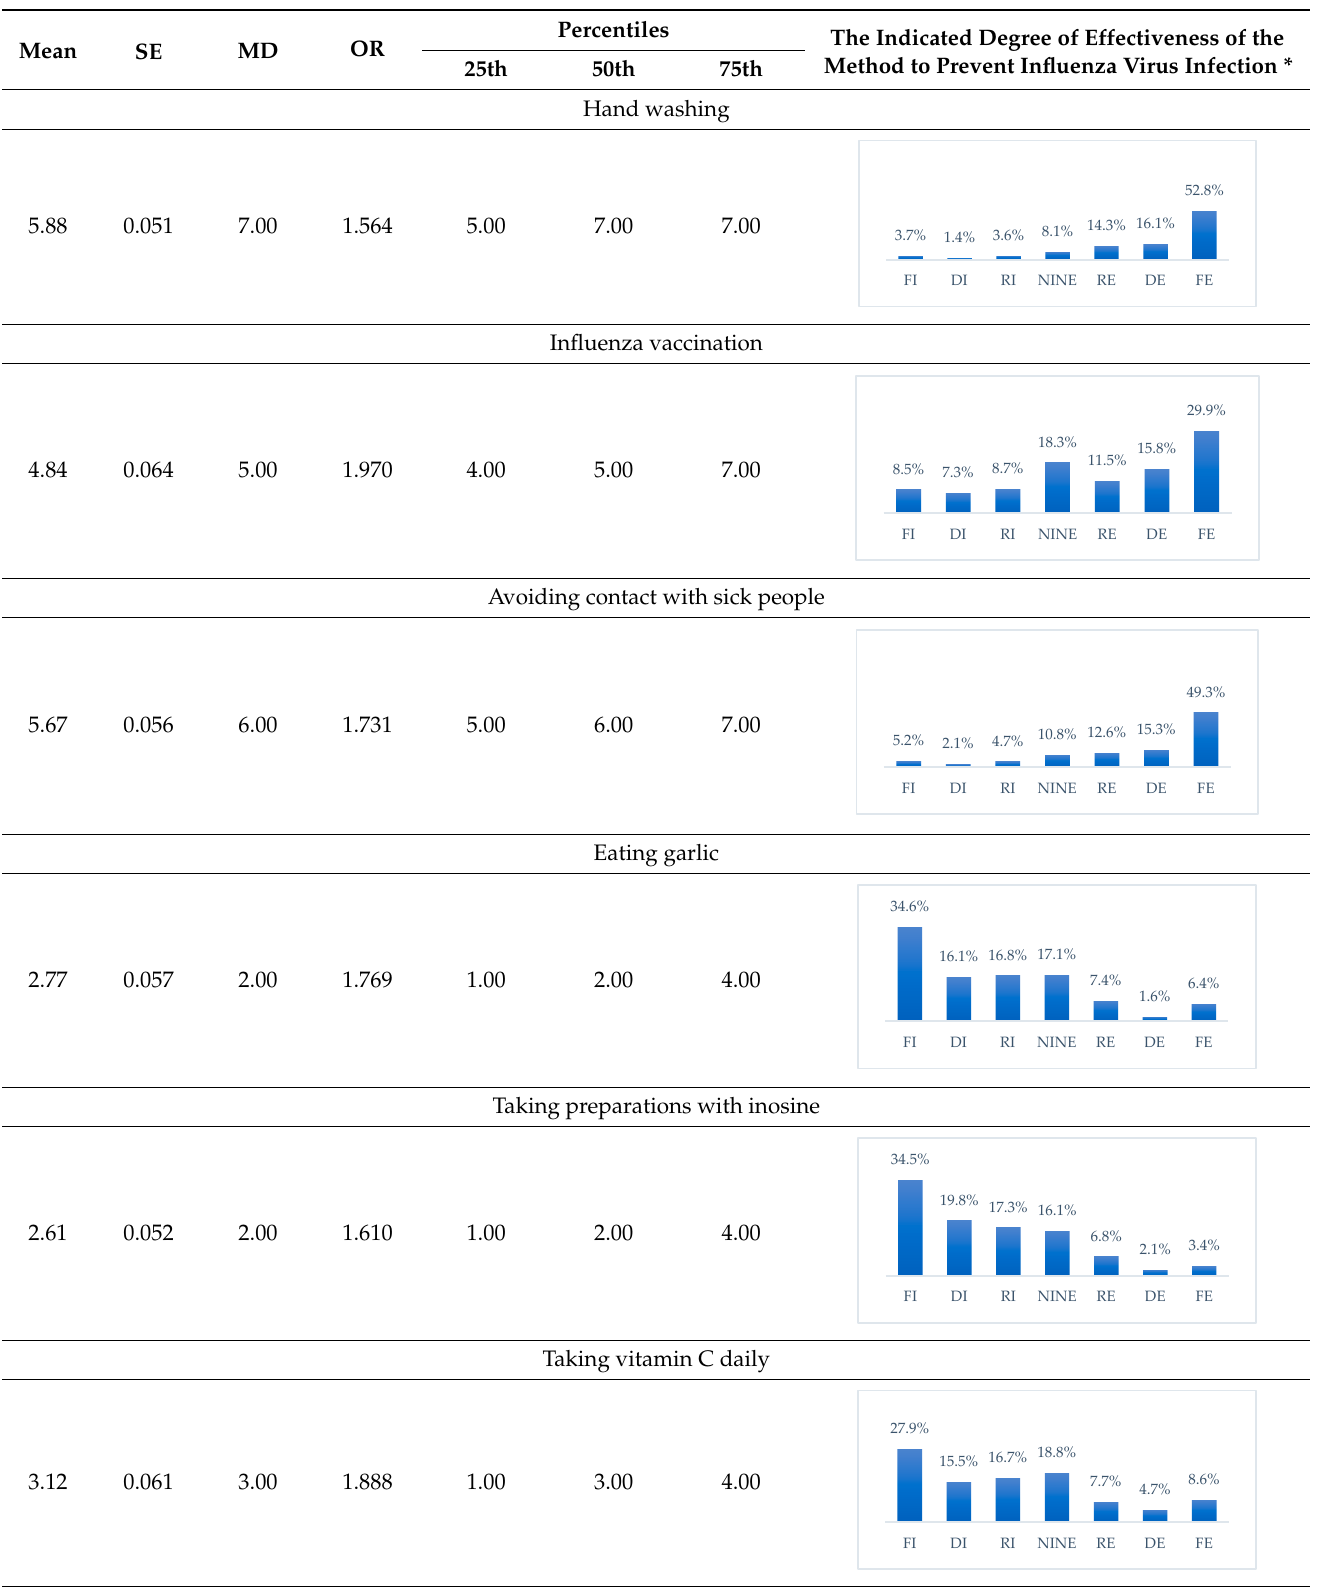
Table 2. Evaluation of the effectiveness of methods to prevent influenza infections ( N = 950).